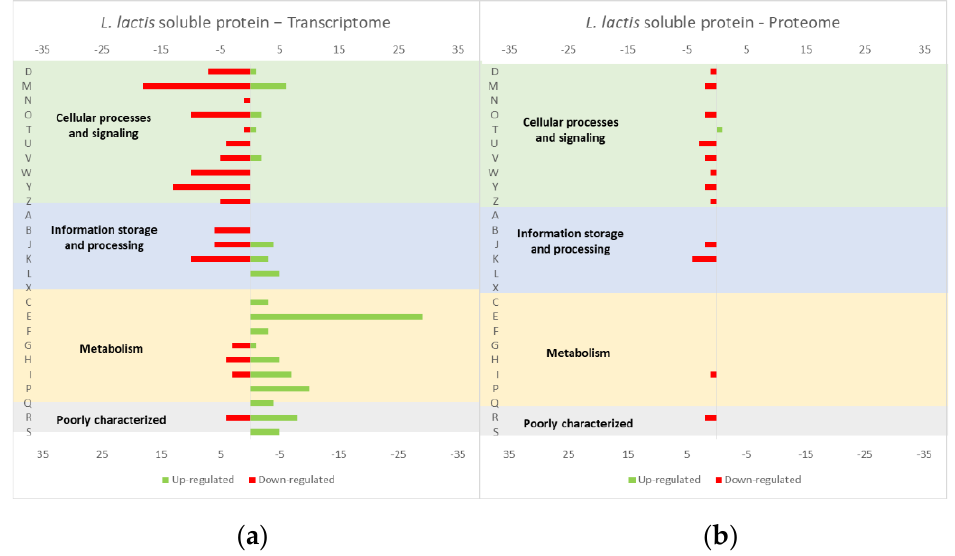
Figure 4. Effect of opuAC (coding for a soluble protein) expression in the L. lactis ( a ) transcriptome and ( b ) proteome. The graphs were constructed with compiled data from Marreddy et al. [30] and represent the total number of transcripts or proteins up or down-regulated in each cellular process, when compared with the strain harboring the empty vector. The letters on the yy axis correspond to the following COG categories: A, RNA processing and modification (not used for prokaryotic COGs), B, chromatin structure and dynamics, C, energy production and conversion, D, cell cycle control and mitosis, E, amino acid metabolism and transport, F, nucleotide metabolism and transport, G, carbohydrate metabolism and transport, H, coenzyme metabolism, I, lipid metabolism, J, translation, K, transcription, L, replication and repair, M, cell wall/membrane/envelope biogenesis, N, Cell motility, O, post-translational modification, protein turnover, chaperone functions, P, Inorganic ion transport and metabolism, Q, secondary metabolites biosynthesis, transport and catabolism, T, signal transduction, U, intracellular trafficking and secretion, Y, nuclear structure (not applicable to prokaryotic COGs), Z, cytoskeleton (not applicable to prokaryotic COGs); R, general functional prediction only (typically, prediction of biochemical activity), S, function unknown [35,36].